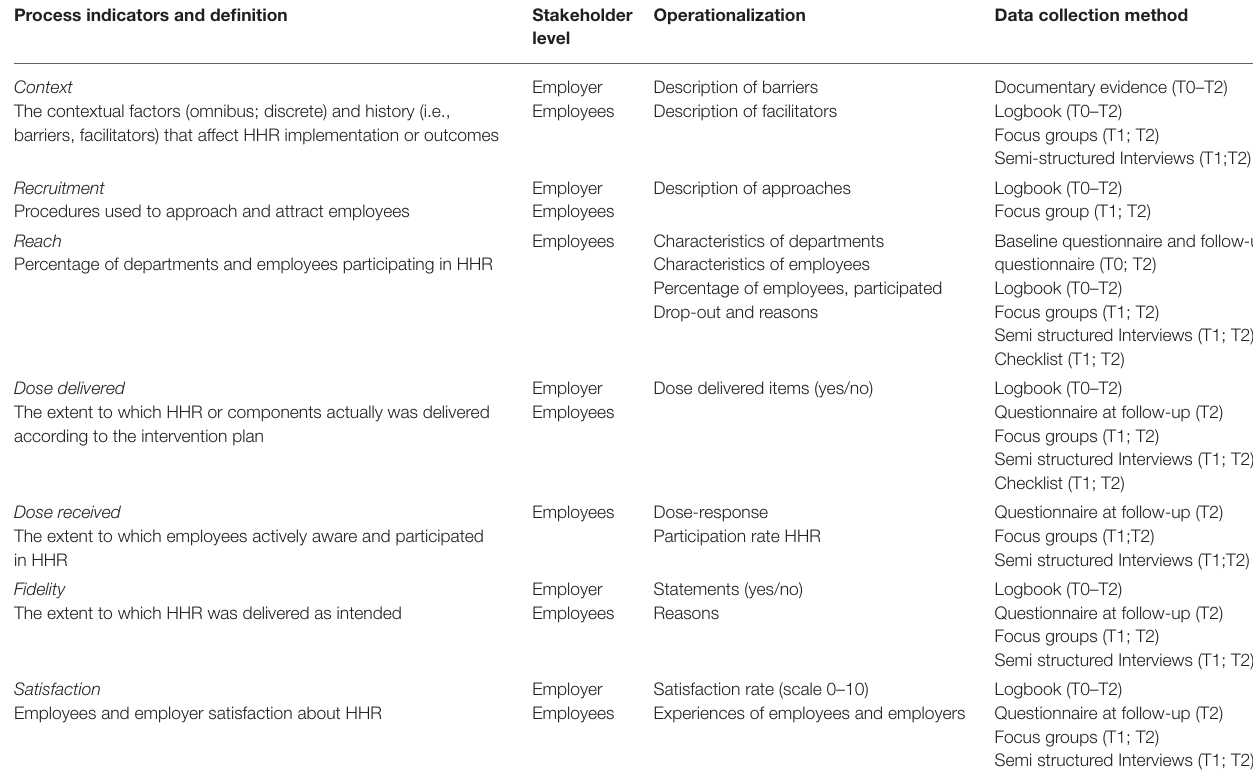
TABLE 1 | Process indicators, stakeholders’ level, operationalization and data collection